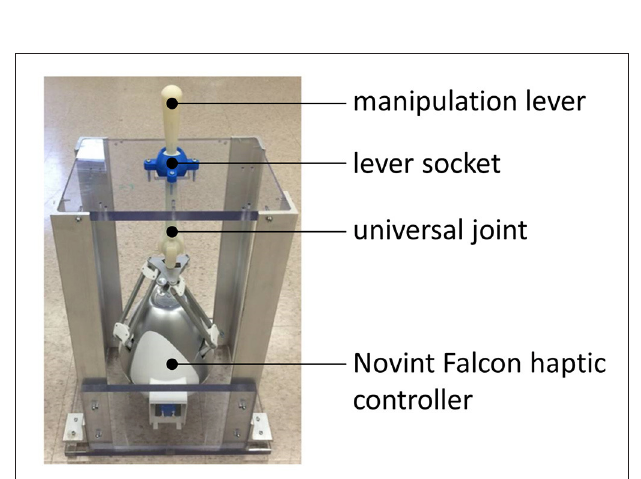
FIGURE 6 | A graphical illustration of the preferred